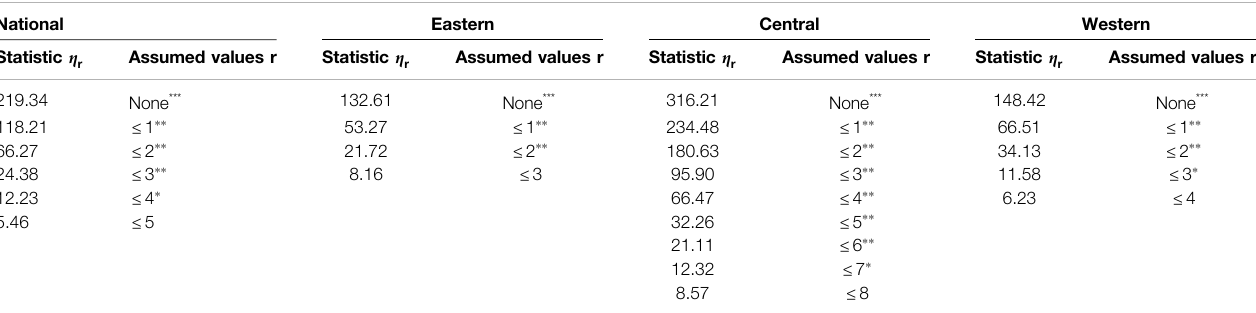
TABLE 5 | Stochastic convergence test results of the innovation ef fi ciency series of each region ’ s high-tech industry. National Eastern Central